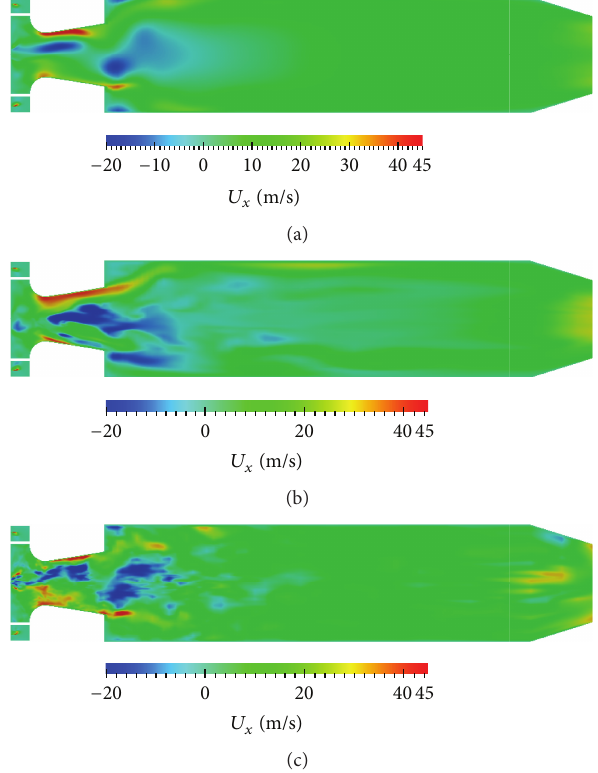
Figure 6: Predicted fields of axial velocity at an arbitrary time step in a plane through combustor by the mixture fraction-reaction progress variable based LFM for NG-FGR20 flame: (a) URANS-SST, (b) URANS-RSM, and (c)